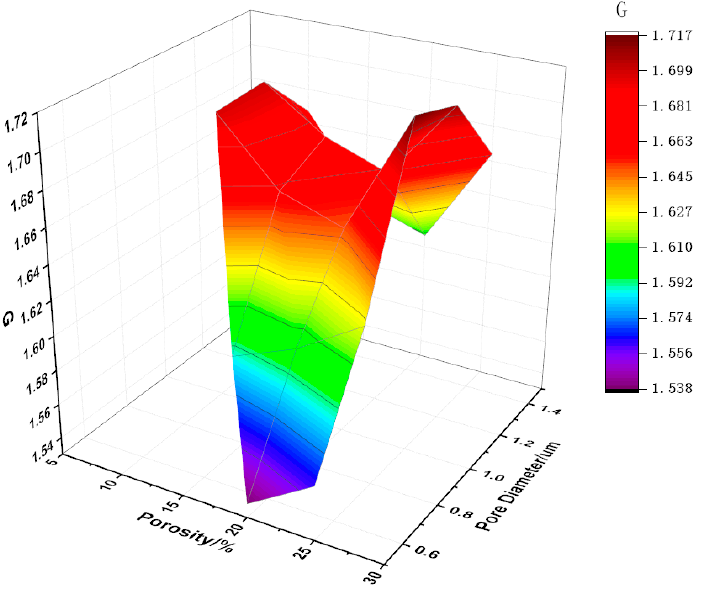
Figure 15. Evaluation results of comprehensive performance calculated by the function.